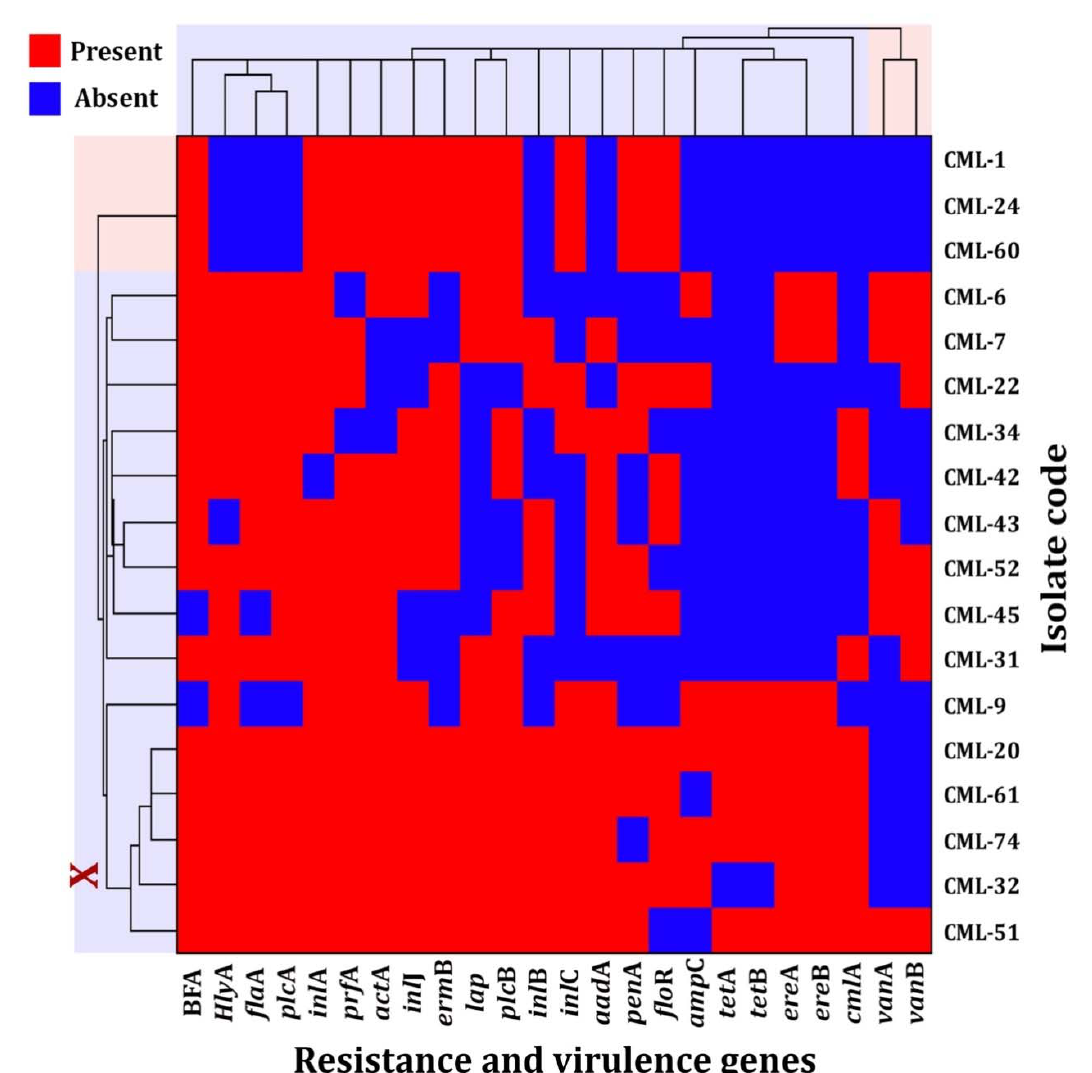
Figure 2. Clustering analysis of resistance and virulence genes-producing MDR L. monocytogenes strains: plc A, plc B, prf A, and act A, LIPI-1 pathogenicity island; inl A, inl B, inl C, and inl J, internalin proteins; lap , adhesion protein; hly A, listeriolysin O gene, flaA , flagellin protein; aad A, aminoglycoside adenyltransferase; amp C, β -lactamase–ampicillin resistance gene; ere A, ere B, and erm B, erythromycin resistance genes; pen A, penicillin-binding protein gene; flo R, florfenicol export protein; cml A, chloramphenicol transporter nonenzymatic chloramphenicol-resistance protein; tet A and tet B, tetracycline resistance genes; van A and van B, vanillate o-demethylase oxygenase subunit; BFA, biofilm-forming ability.